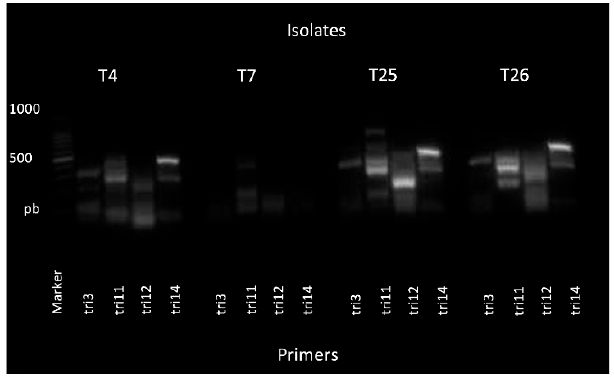
Figure 4. Gel electrophoresis of the PCR products obtained from Trichoderma afroharzianum (isolate T-7), T. atroviride (isolates T4 and T25) and T. harzianum (isolate T26), using the primer pairs corresponding to the trichothecene genes Tri -3, Tri -11, Tri -12 and Tri -14. Table 2. BLAST best matches of the sequenced Tri genes amplicons from the Trichoderma spp. isolates. Isolate